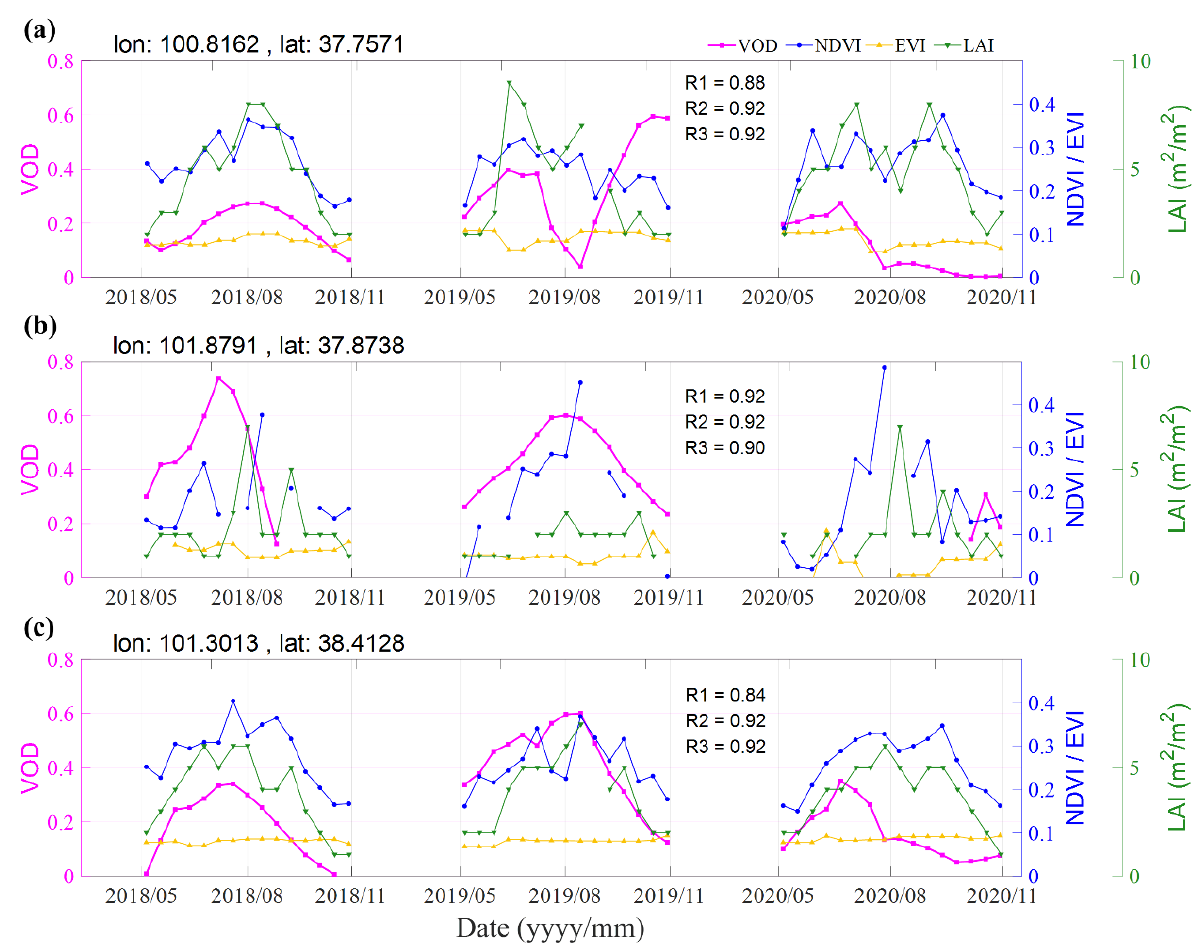
Figure 8. Time-series of VOD and VIs at three sampling points: ( a ) site a, ( b ) site b, ( c ) site c. (their locations are shown in Figure 1). Note: R1, R2, R3 are the correlations computed between VOD and NDVI, EVI and LAI, respectively.